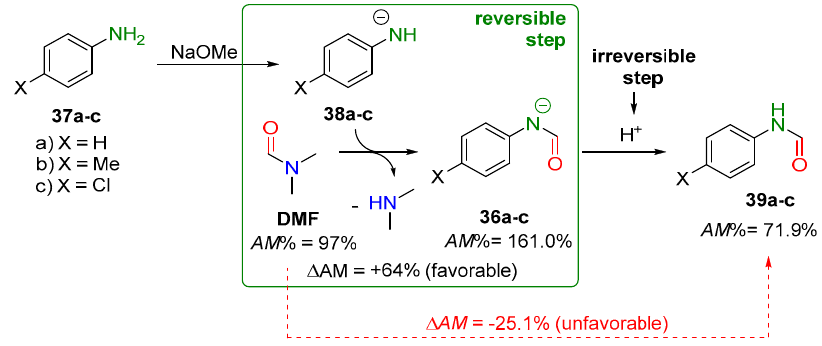
Figure 15. An example for case IV transamidation reaction with the corresponding amidicity values computed at B3LYP/6-31G(d,p) level of theory. The green box illustrates the thermodynamically favorable subprocess, while the red arrow shows the overall unfavorable reaction.